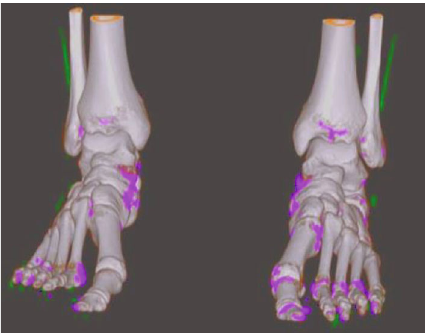
Figure 3: Dual-energy CT demonstrating sodium monourate deposits in both